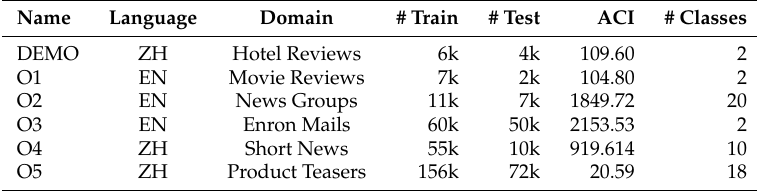
Table 9. Text: Characteristics of the used textual datasets; ACI refers to the average number of characters per